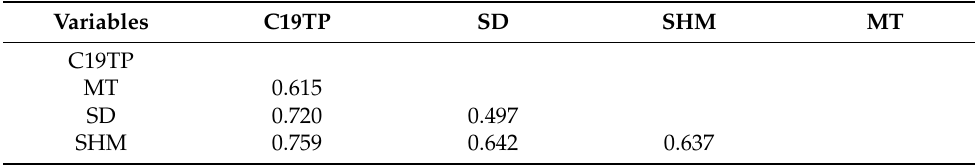
Table 8. Heterotrait–monotrait ratio